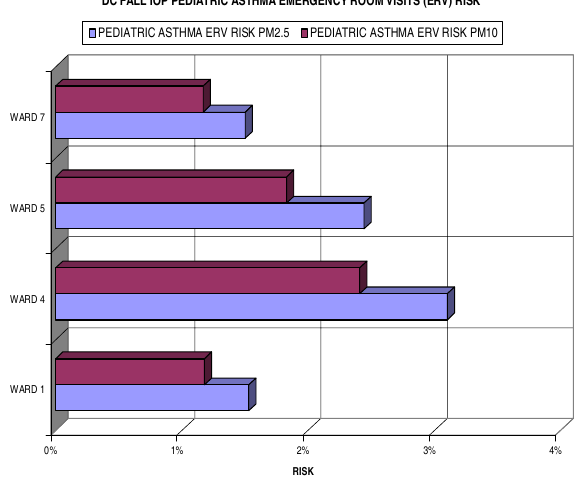
Figure 8: Fall IOP Pediatric Asthma ERV Excess Risk Using equation 5, these individual risk values may be converted into new cases of pediatric asthma ERV or the number of persons that may be affected by the exposure in a specified population. According to the 2000 DC State Data Center report [10], the population of youth (under 18 years of age) for Wards 1, 4, 5, and 7 in Washington, DC was 63,540 in total, as shown in Table